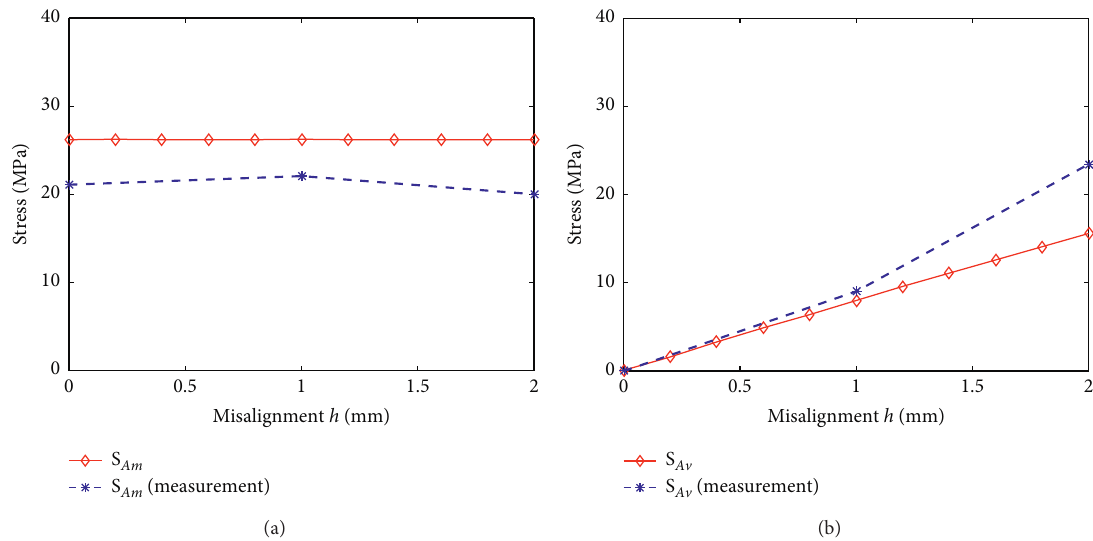
Figure 11: Comparison of the stress amplitudes and static stress for the measured and simulated results. (a) Comparison of the stress amplitudes. (b) Comparison of static stress.